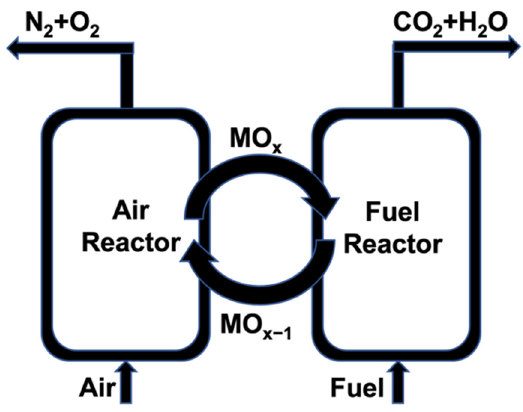
Figure 1. Schematic description of chemical-looping combustion.